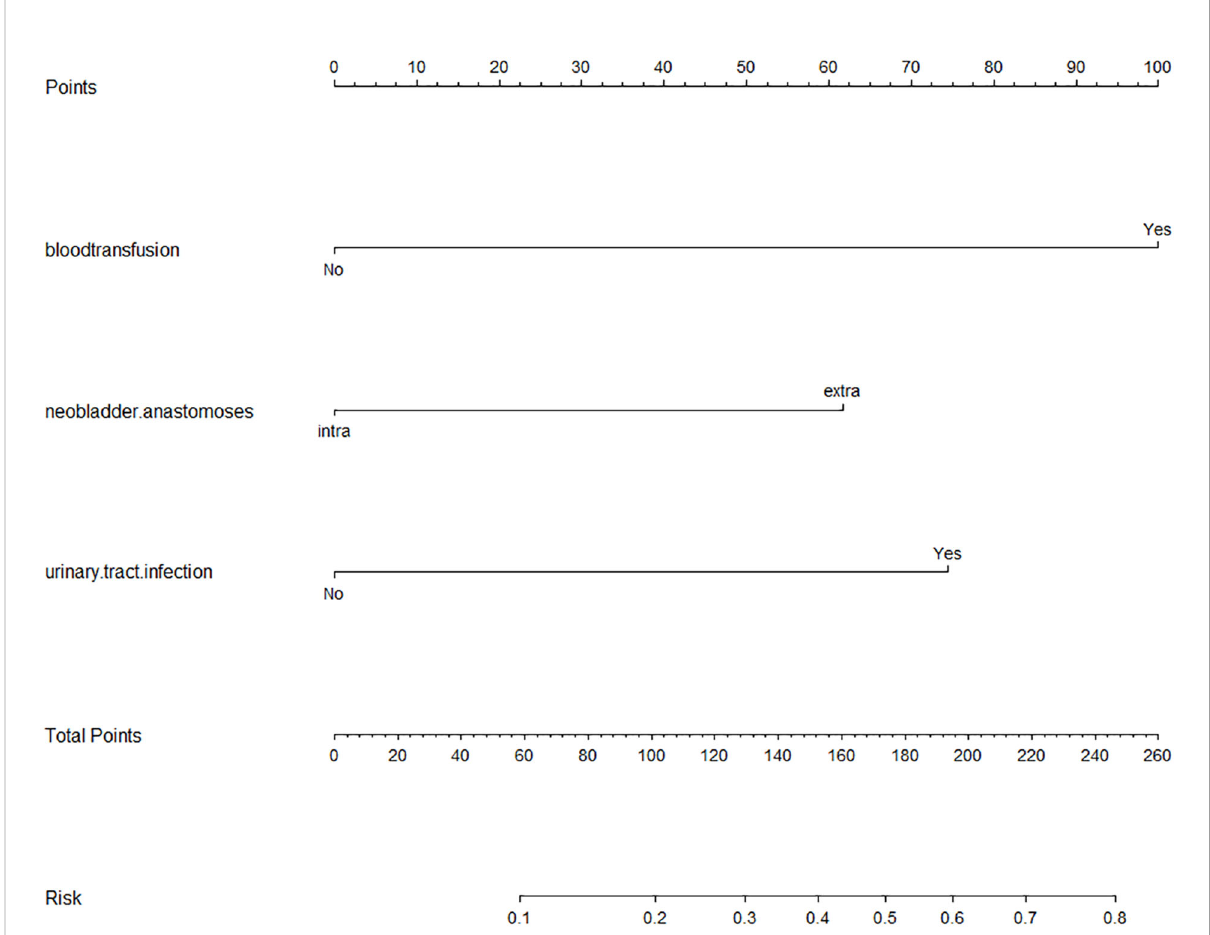
FIGURE 2 Nomogram based on Logistic regression model. Abbreviations: HR, hazard ratio. The scores of the three risk factors are added together to form the total score, ranging from 0 to 260 points. The percentage corresponding to the total score downward is the probability of UIAS in patients with Radical cystectomy with urinary